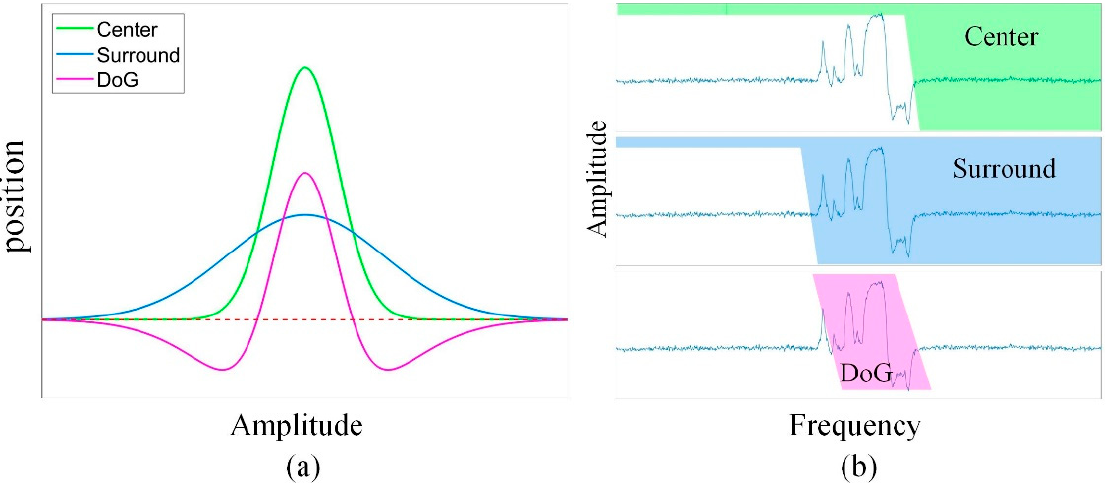
Figure 1. The illustration of a DoG filter: ( a ) The operator can be regarded as a narrow-center Gaussian filter subtracted by a wider one; ( b ) the band-pass filter generated by two low-pass filters with different cut-off frequencies.